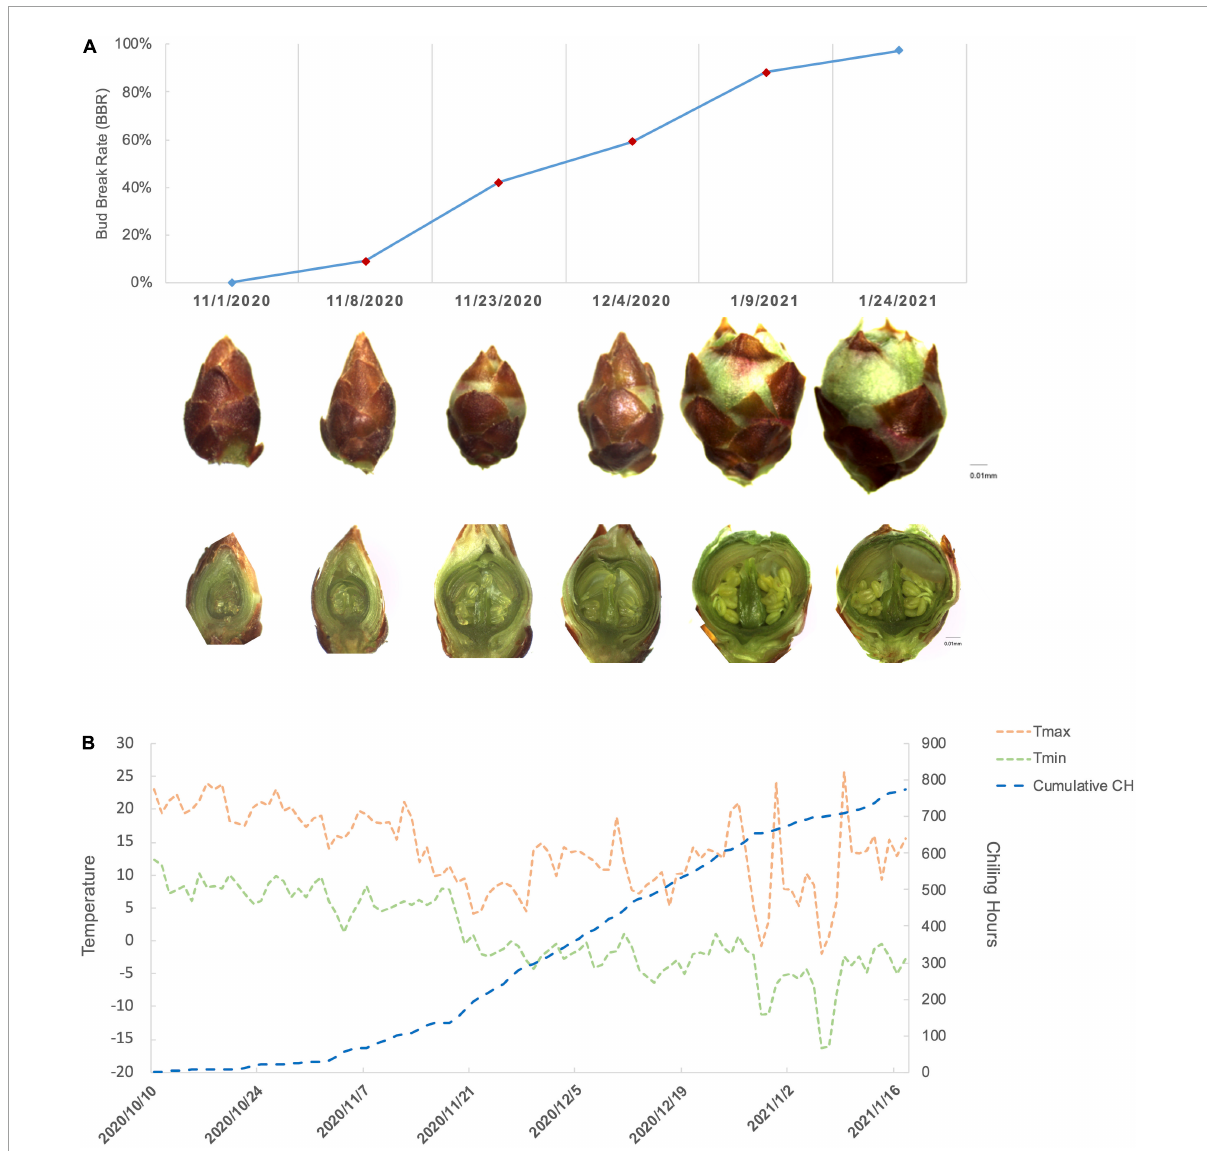
FIGURE1 The characterization of floral bud development for P. mume cultivar “Subaitaige” during dormancy release in 2020–2021. (A) The floral bud dormancy status and inner structure changes of floral bud sampled during dormancy release and bud flush. The longitudinal sections of flower buds were compared between sampling time points. (B) The daily maximum temperature, minimum temperature, and cumulative chilling hours were evaluated since October 10th, 2020 till January 24th, 2021 using chilling hour